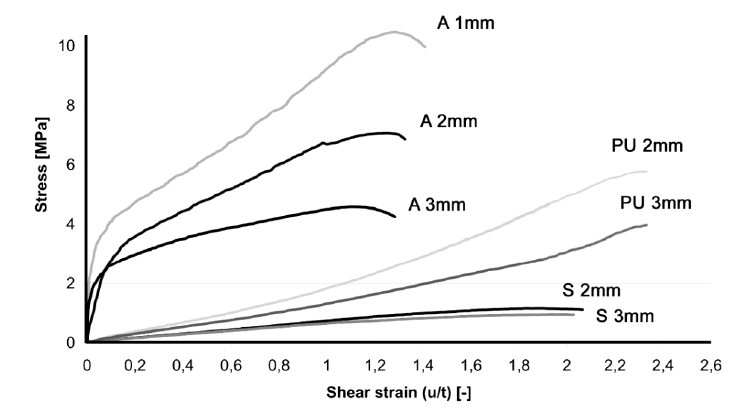
Figure 7: Stress-strain diagrams of the glued connections subjected to shear (S- silicone, A- acrylic, PU- Polyurethane booster system).